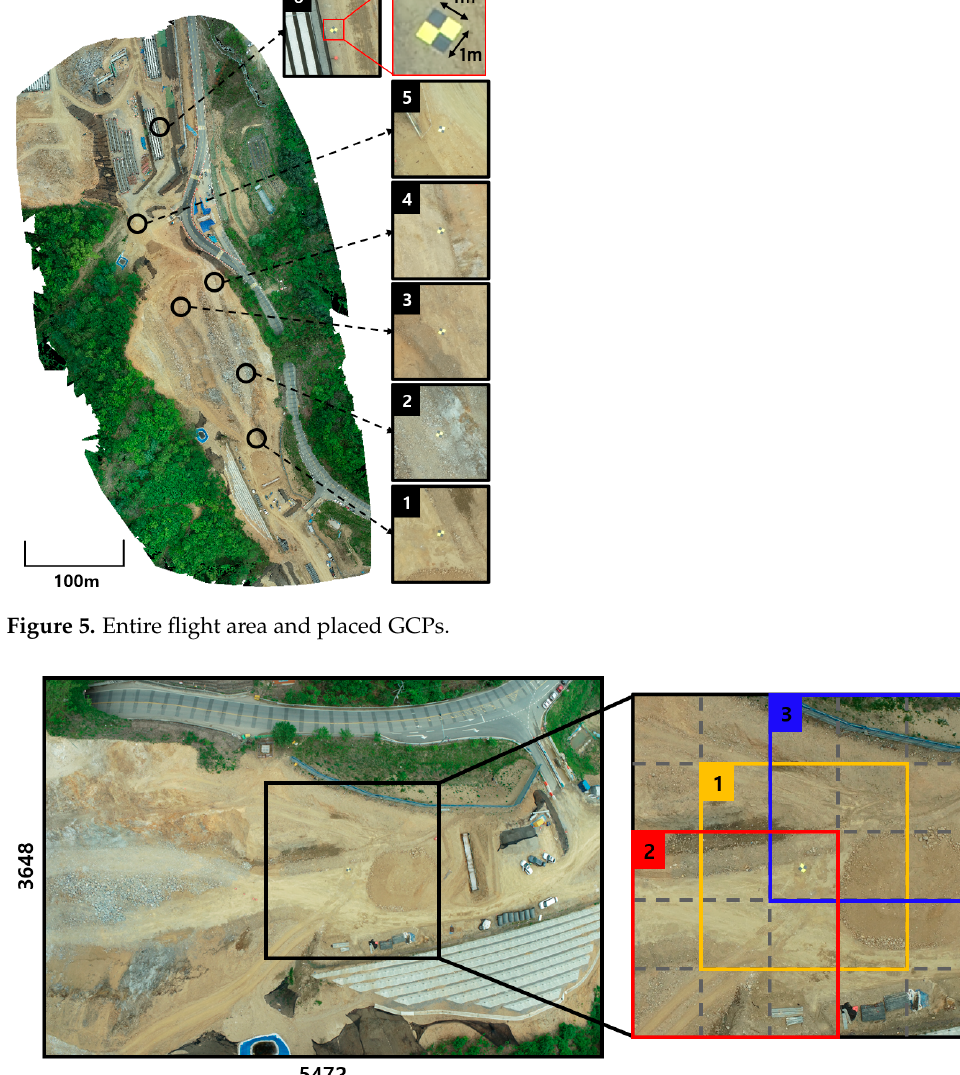
Figure 5. Entire flight area and placed GCPs.